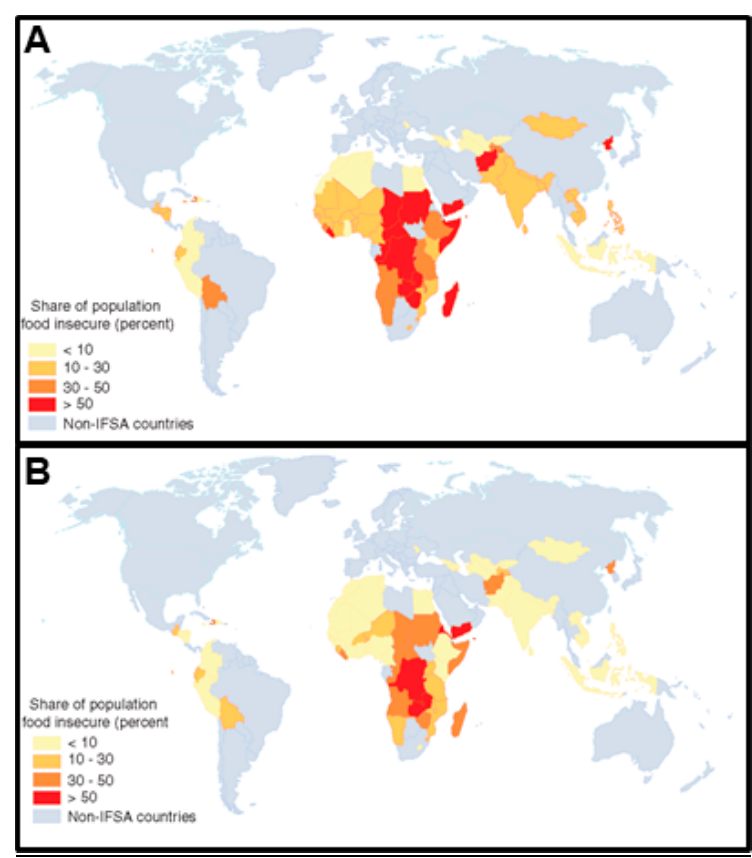
Figure 2. ( A ) Share of population that was food insecure in 2019 and ( B ) projected to be insecure in 2029. Grey corresponds to regions where data is unavailable [31].